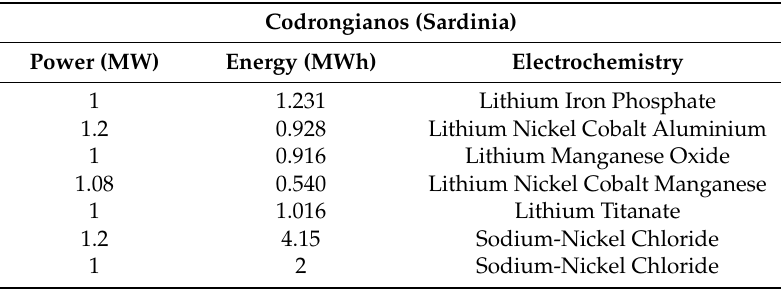
Table 3. Different storage technologies installed in Codrongianos (Sardinia).